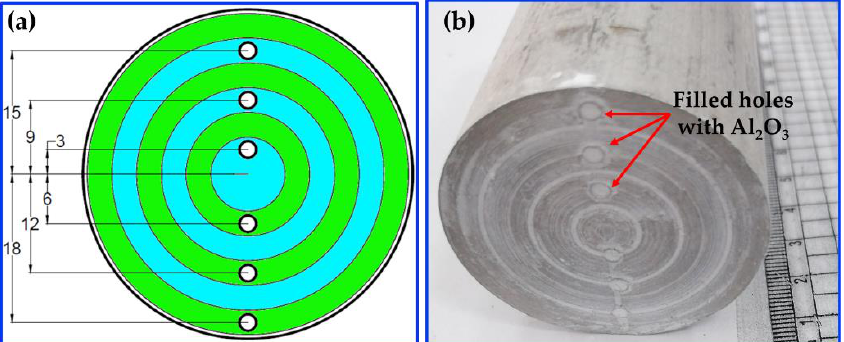
Figure 2. ( a ) Design sketch of the machined holes; ( b ) the holes filled with Al 2 O 3 .